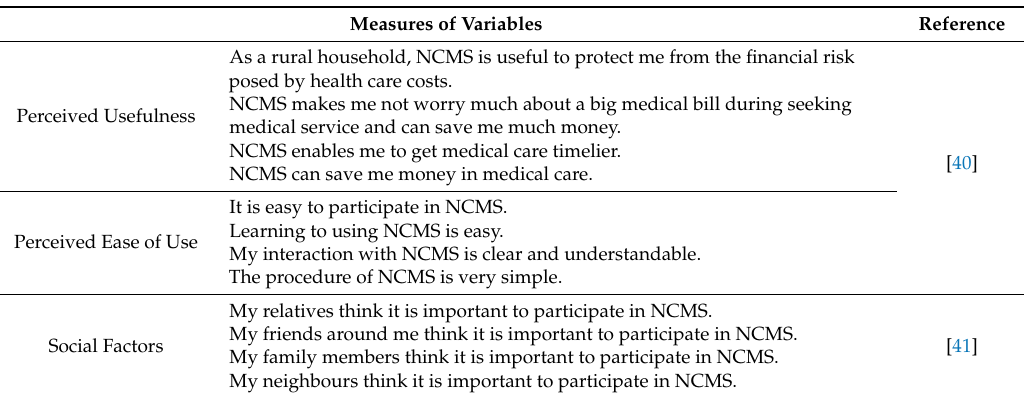
Table 1. Measures of